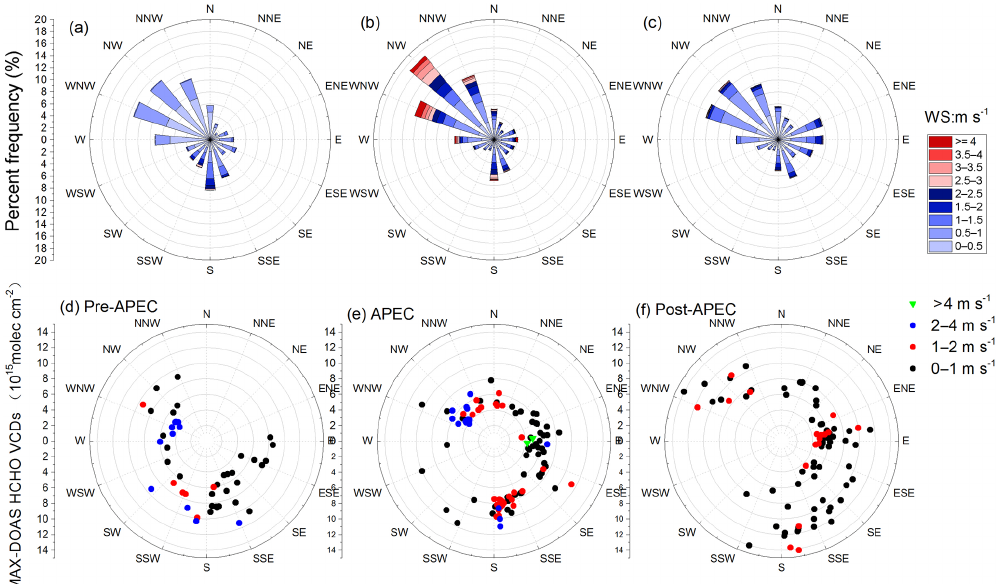
Figure 12. Wind roses in (a) the pre-APEC, (b) the APEC, and (c) the post-APEC periods. Dependence of HCHO VCDs (10 15 moleculescm − 2 ) on wind directions for different wind speeds in the pre-APEC (d) , during the APEC (e) , and post-APEC (f) peri- ods.